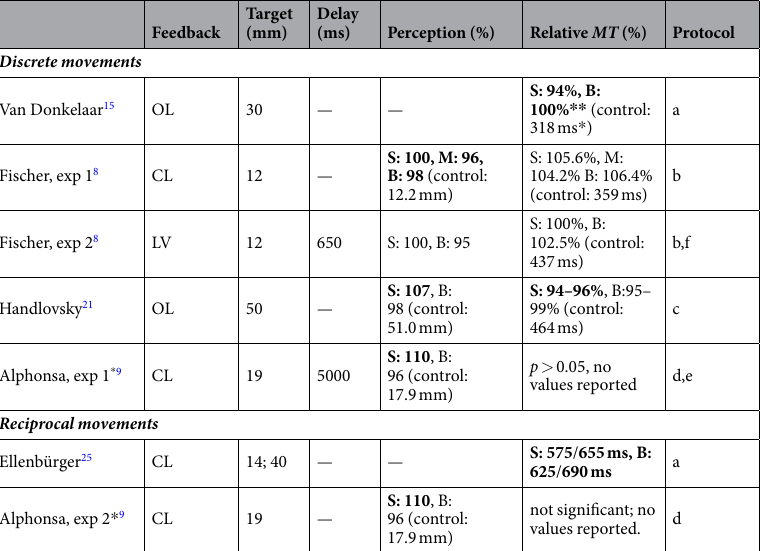
Table 1. Effects of Ebbinghaus-like figures on size perception and duration of pointing movements. All illusion effects are relative to the control condition in percentage if the control condition was present, and marked bold if significant at the p < 0.05 level. Else, the values in mm or ms were reported. The illusion conditions consist of Ebbinghaus figures with a small (S), medium (M), or big (B) context size. The visual feedback is classified as open-loop (OL), closed-loop (CL), and limited vision tasks. * The exact MT s are not reported. ** The MT s are not related to a control condition in the study. Experimental conditions: (a) simultaneous presentation of a target with a small context on one side, and a big context on the other side, (b) only the target is surrounded by contexts, (c) the home position as the target could be surrounded symmetrically and asymmetrically by a small, big, or no context size, (d) the symmetric display of the left and right target with, or without context